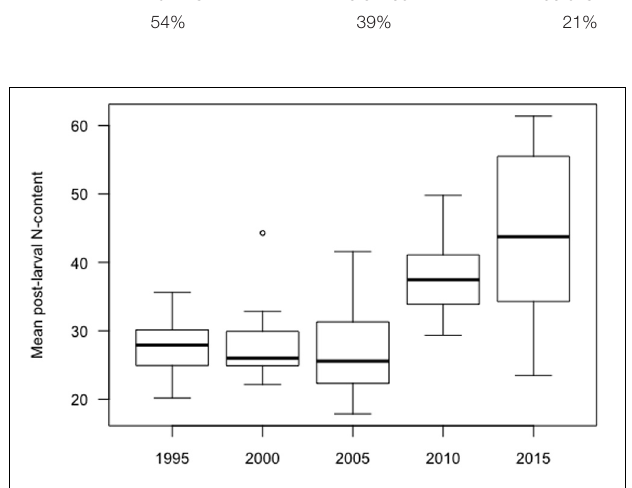
FIGURE 4 | The N-content per spot ( NPS ), i.e., the ratio of 12 C 14 N − / 40 Ca − , versus the distance ( µ m) from the otolith core to the edge of the otoliths, for